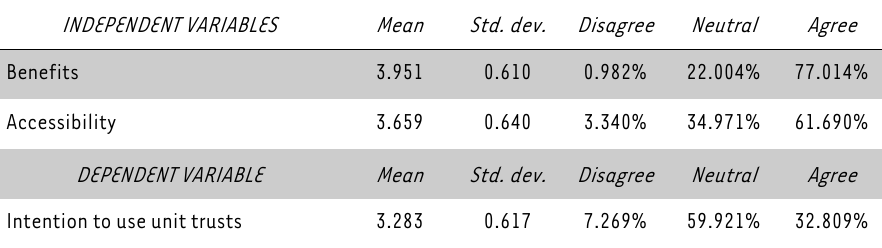
Descriptive statistics of variables INDEPENDENT